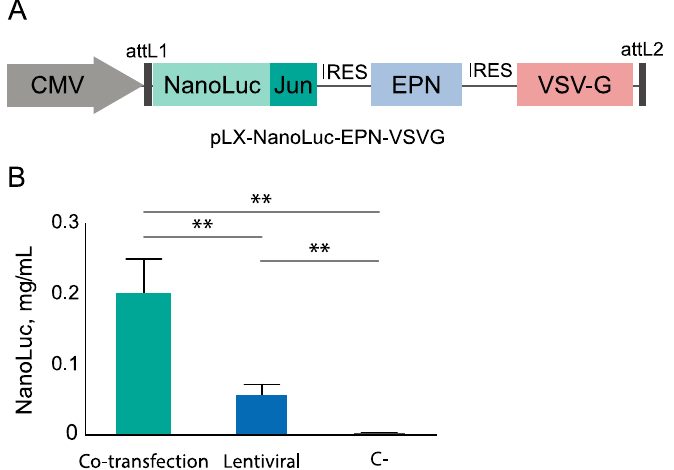
Figure 4. ( A ) Construction of the pLX-NanoLuc-EPN-VSV-G vector. NanoLuc-Jun/EPN/VSVG genes are separated via IRES sequences. ( B ) Comparison of EV production efficiency utilizing co- transfection of three vectors (pCMV-VSVG, pCMV-EPN-Fos-C, pCMV-NanoLuc-Jun) and utilizing lentiviruses. For each analysis, samples were concentrated with 100 kDa membrane and washed three times with PBS to remove NanoLuc which is not encapsulated in EVs. NanoLuc-Jun amounts in EVs were measured via NanoGlo assay, utilizing prokaryotic NanoLuc-Jun protein for calibration. ** p < 0.01, two-tailed Student’s t -test (n =